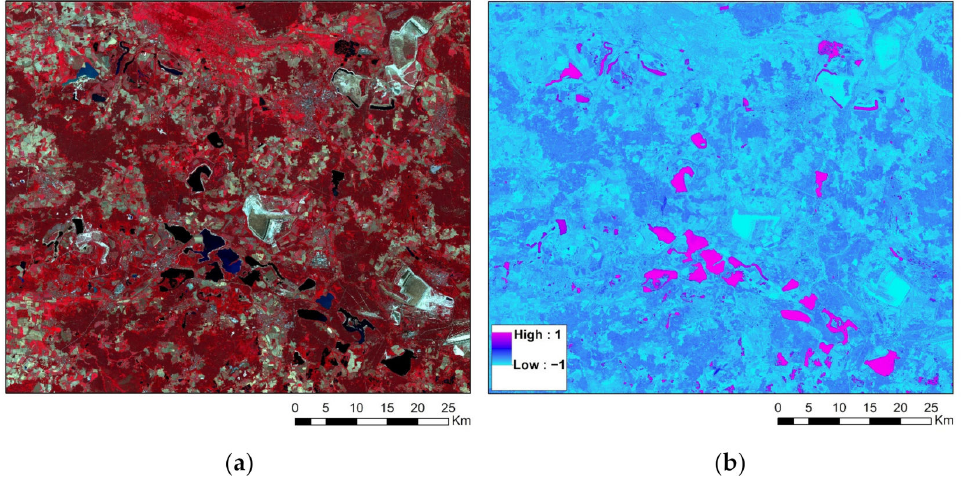
Figure 9. ( a ) False-color image over the Lusatia region (bands 8-4-3) acquired in August 2020; ( b ) The mNDWI